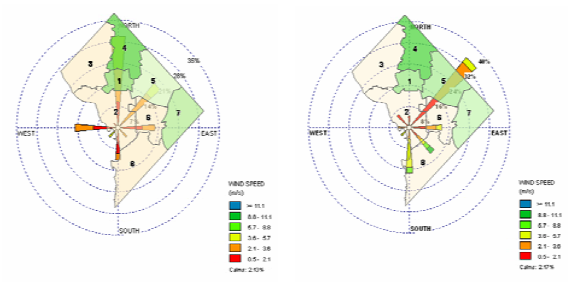
Summer and Fall IOP (Respectively) Figure 2: PM 2.5 Wind Rose Plot